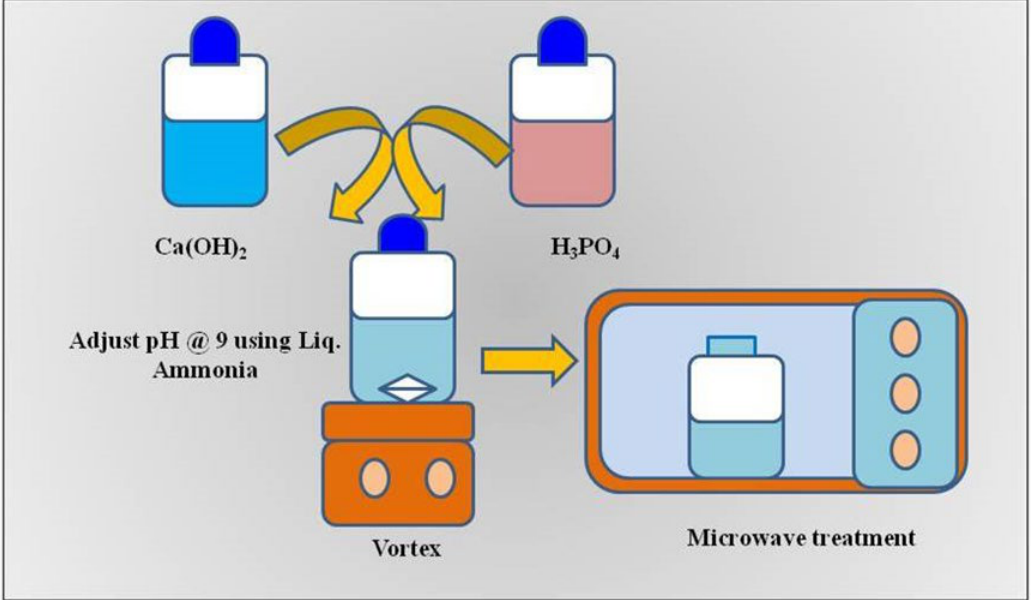
Figure 1. Schematic presentation illustrating the microwave-assisted synthesis of HANPs.